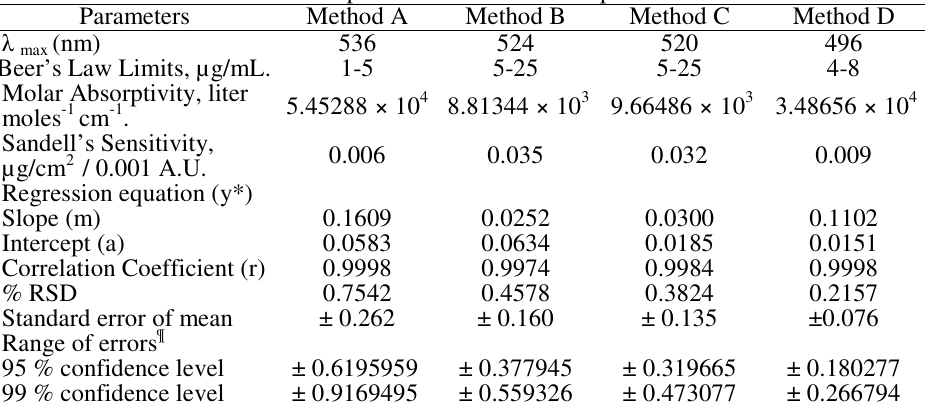
Table 1. Optical characteristics and precision.